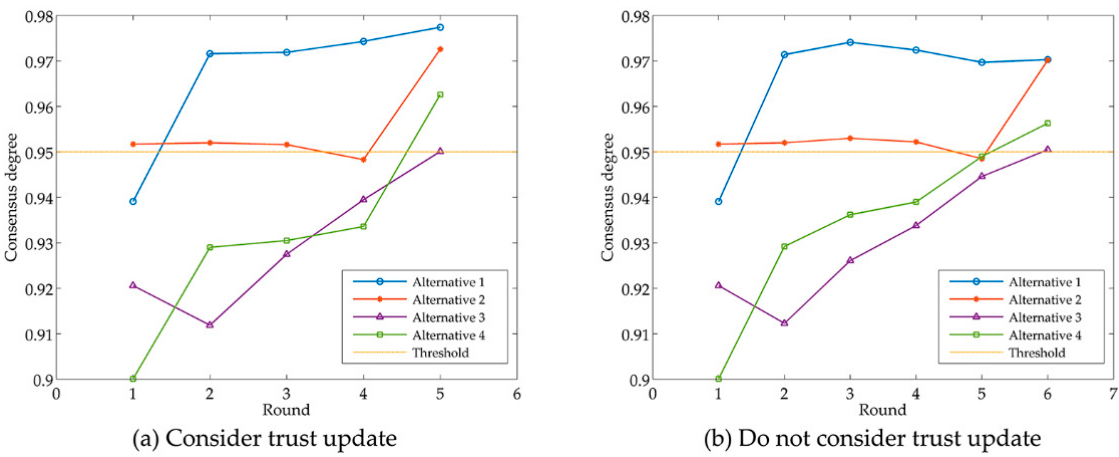
Figure 6. Consensus degree of the alternatives at each opinion interaction stage.